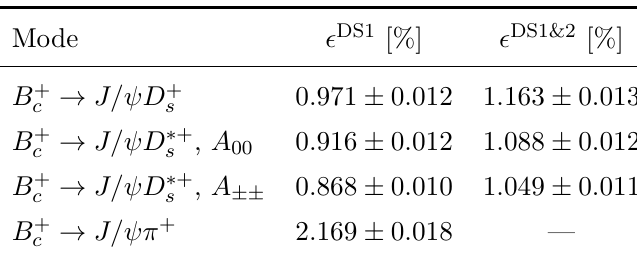
— Table 3 . Summary of the total efficiencies. Quoted uncertainties correspond to statistical uncer- tainties of the simulated samples. For the B + entering → J/ψπ + channel, the efficiency (cid:15) c B + c → J/ψπ + the equations for R is shown, while the efficiency for the full dataset is not D ( ∗ )+ s /π +